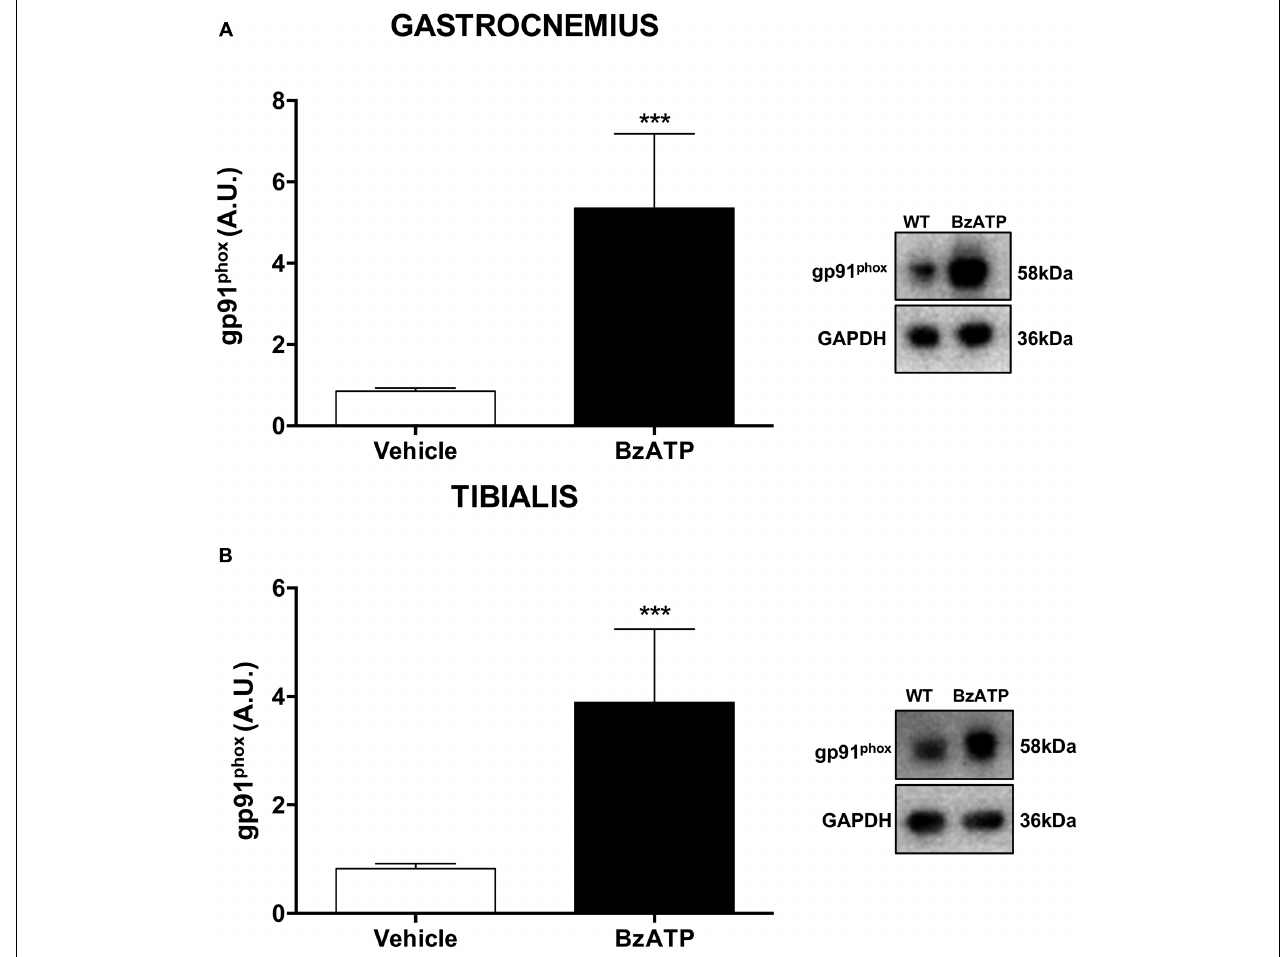
FIGURE 4 | BzATP enhances gp91phox expression in skeletal muscles of C57BL/6J mice. An equal amount of total gastrocnemius (A) and tibialis anterior (B) muscle lysates from vehicle and BzATP- treated mice ( n = 3/group) were subjected to SDS-PAGE and Western Blotting with anti-gp91 phox . GAPDH was used for protein normalization. Data represent means ± SEM. Statistical significance was calculated by Student’s t -test, as referred to vehicle, ∗ p <